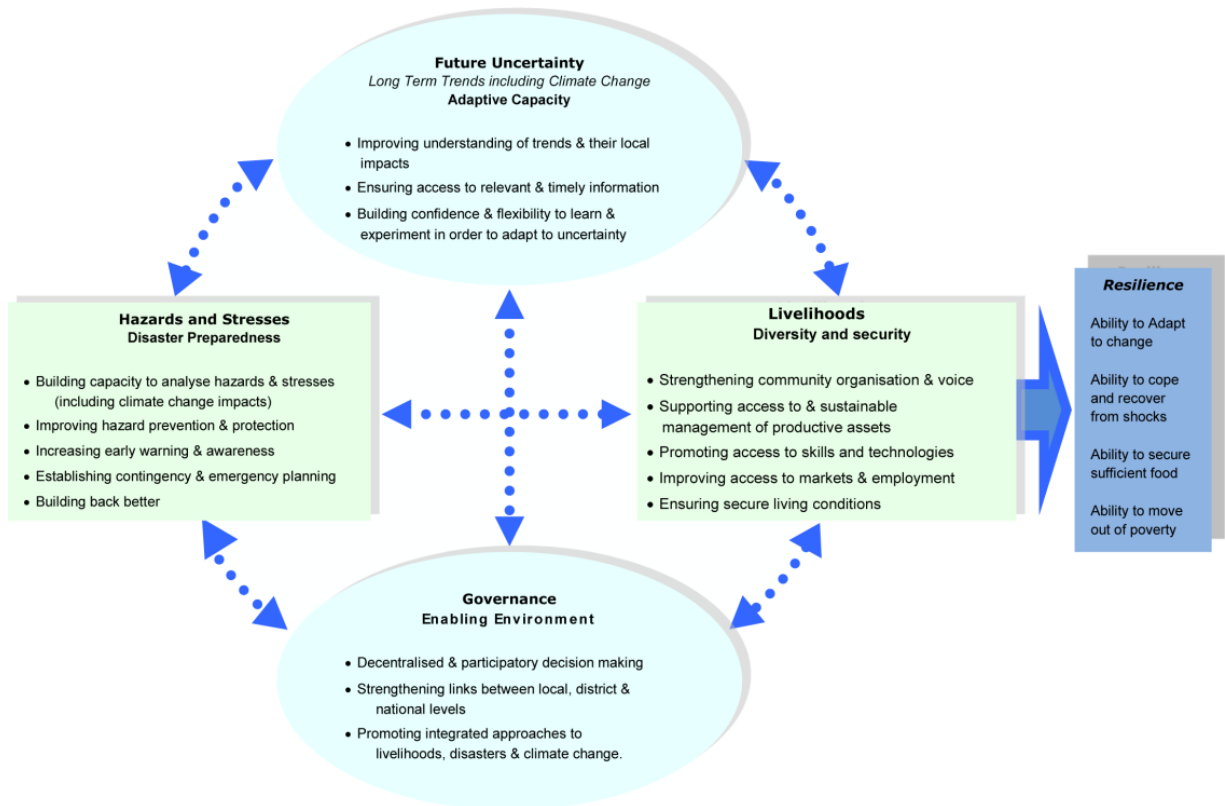
Figure 2: Vulnerability to Resilience Framework. Source: Pasteur, 2011 5 Figure 2. Vulnerability to Resilience framework (source: Pasteur, 2011). 4. D for significantly below good standard, with potential for imminent